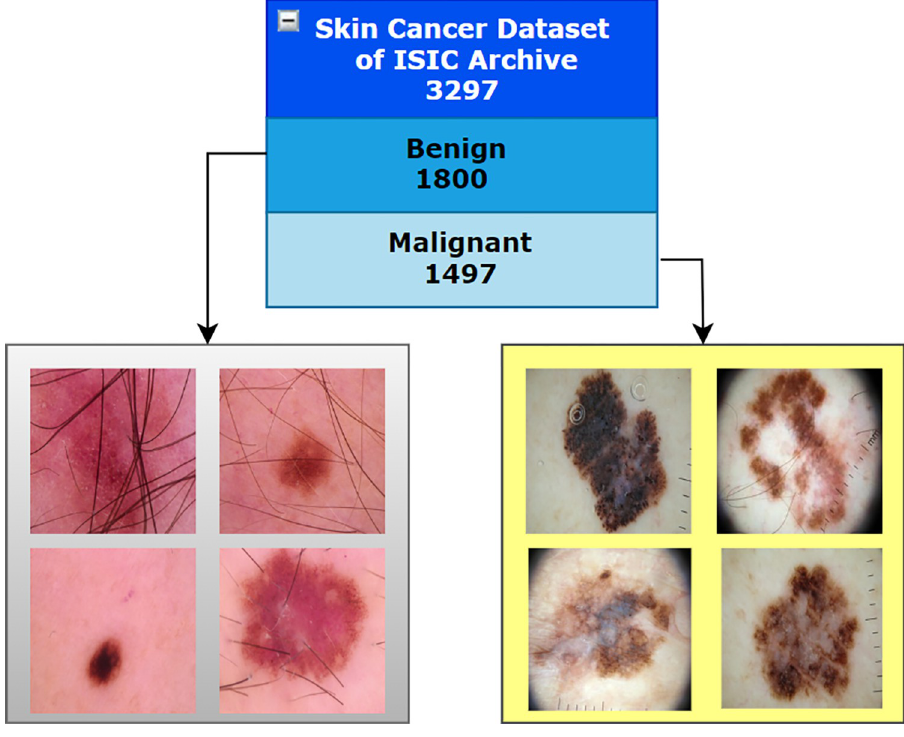
Fig 2. Skin cancer ISIC archive